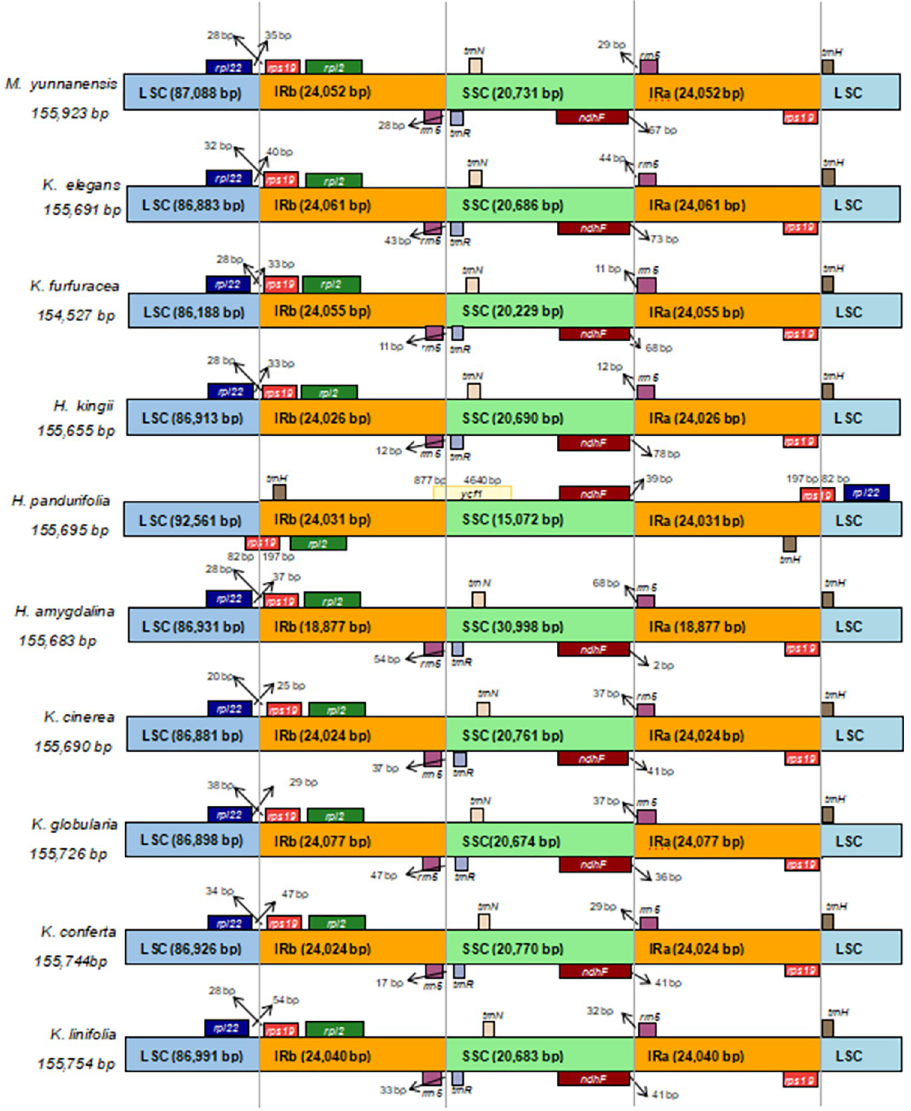
Fig 7. Comparison of the borders of the IR, SSC and LSC regions among ten chloroplast genome of Myristicaceae.